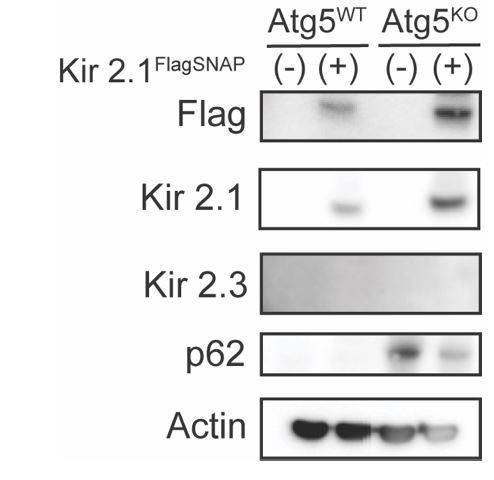
Specificity of Kir2.1 antibody.Lysates were generated from Atg5WT and Atg5KO MEFs, with or without transfection with Kir2.1FlagSNAP and blotted for Flag, Kir2.1, Kir2.3, p62 and actin.